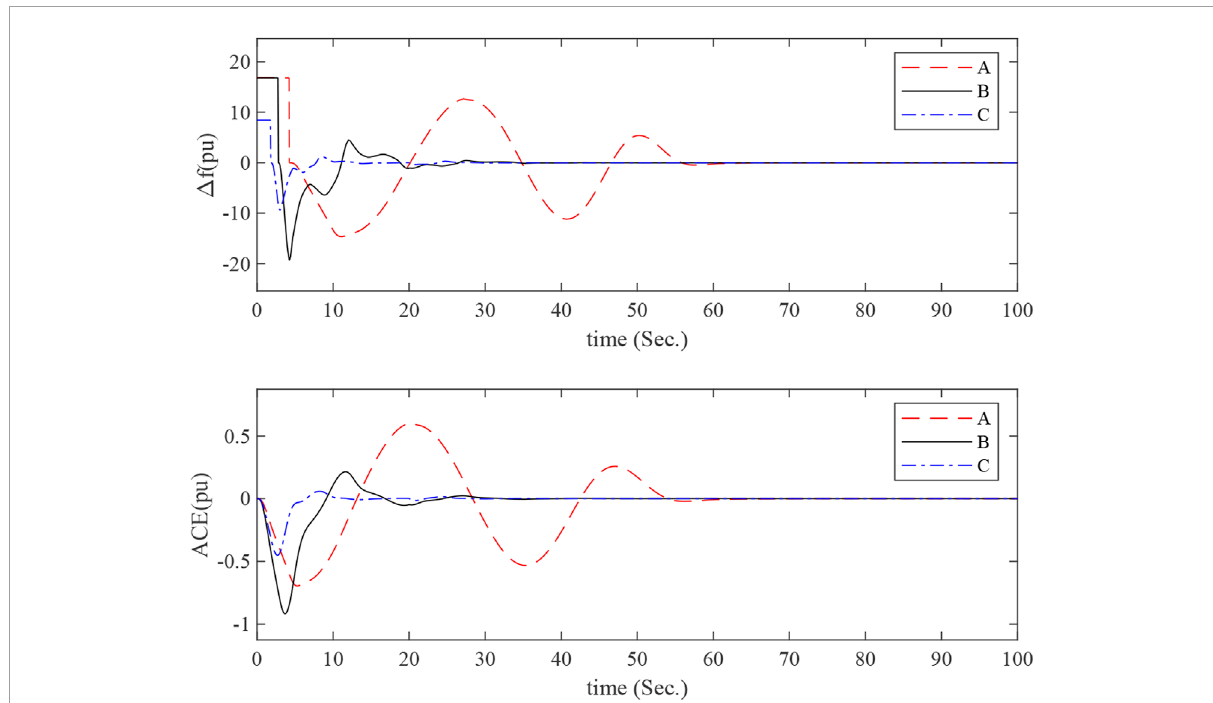
FIGURE 2 Frequency deviation and control error responses of the one-area LFC power system with K P = 0 and different K I .